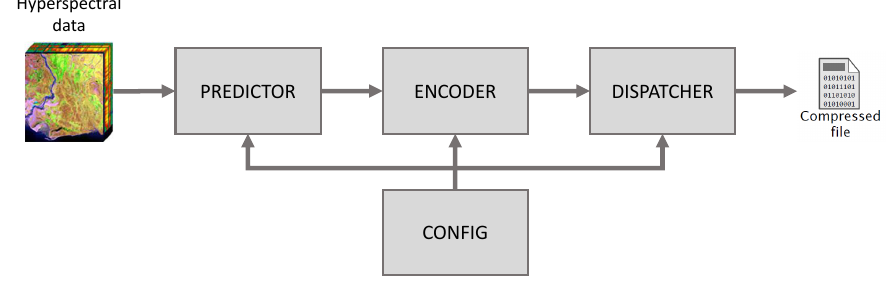
Figure 5. Block diagram of the CCSDS-123 IP core